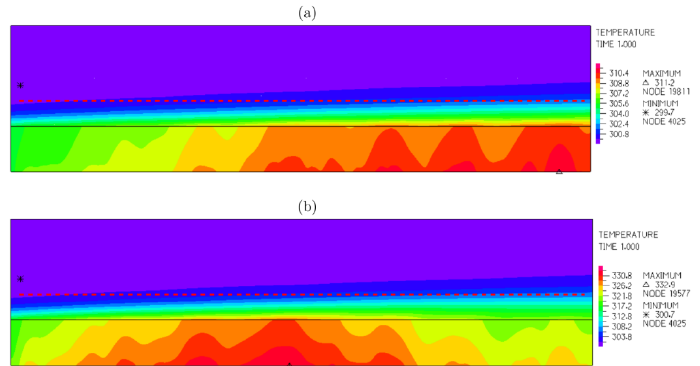
Figure 10. Distribution of temperature in the foil and in the fluid obtained from the FEM computations carried out by ADINA software; the test section with three minichannels; experimental parameters listed in Table 2; heat flux values: ( a ) q’’ = 68 kW/m 2 ; ( b ) q’’ = 123.5 kW/m 2 . Energies 2020 , 13 , x FOR PEER REVIEW